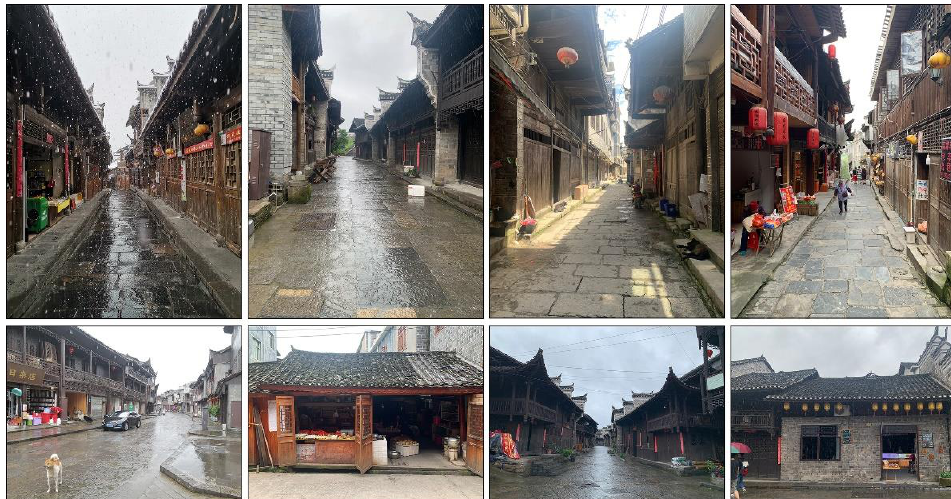
Figure 2. Xiangxi Tujia ancient town houses.